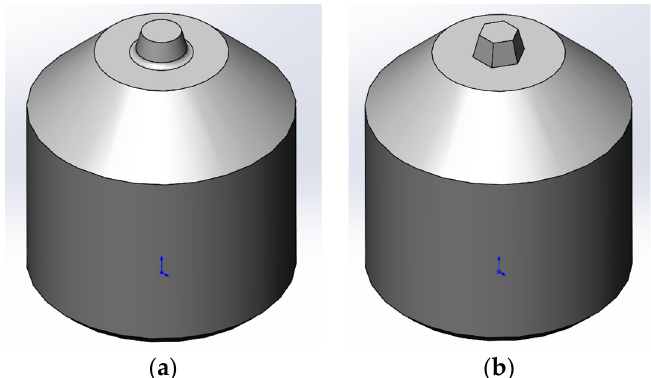
Figure 1. Microstructures of base material: ( a ) optical image transverse to the rolling direction; ( b ) optical image in longitudinal direction (rolling direction).